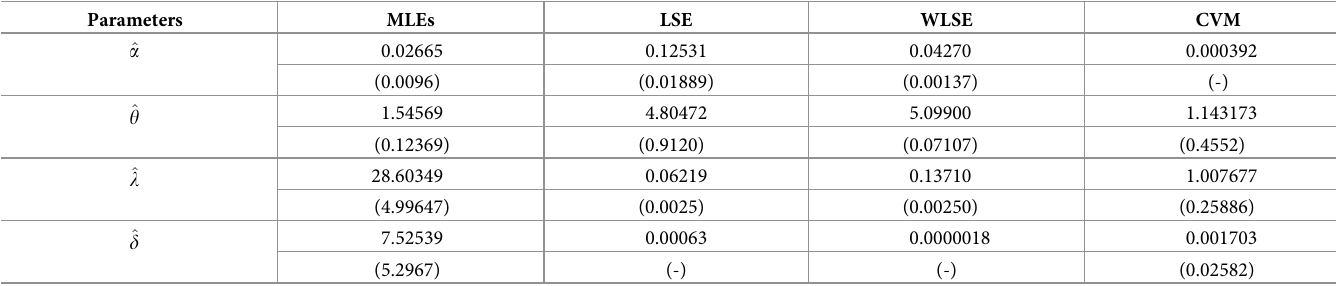
Table 3. Estimated parameters’ value from four different methods.